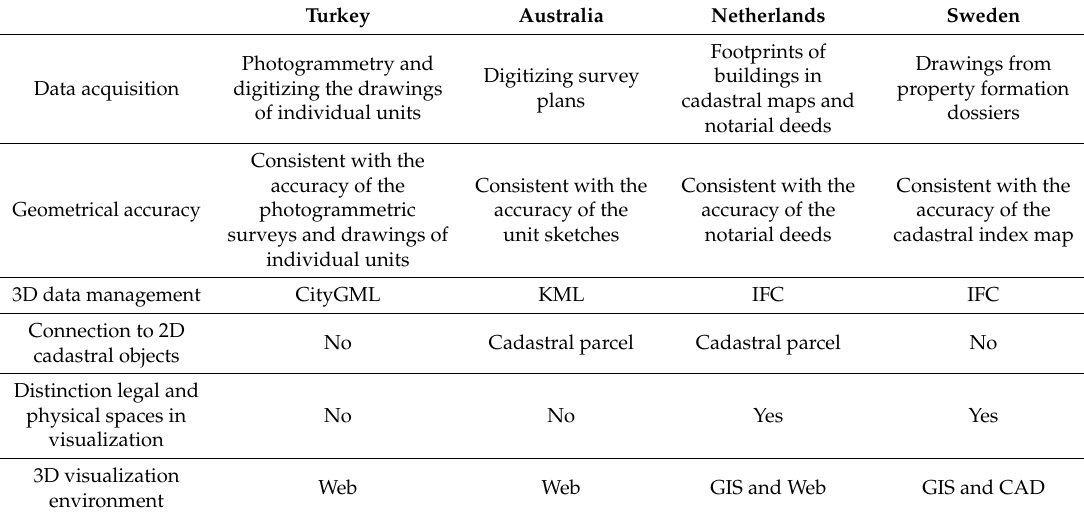
Table 1. 3D representation of cadastral data in four